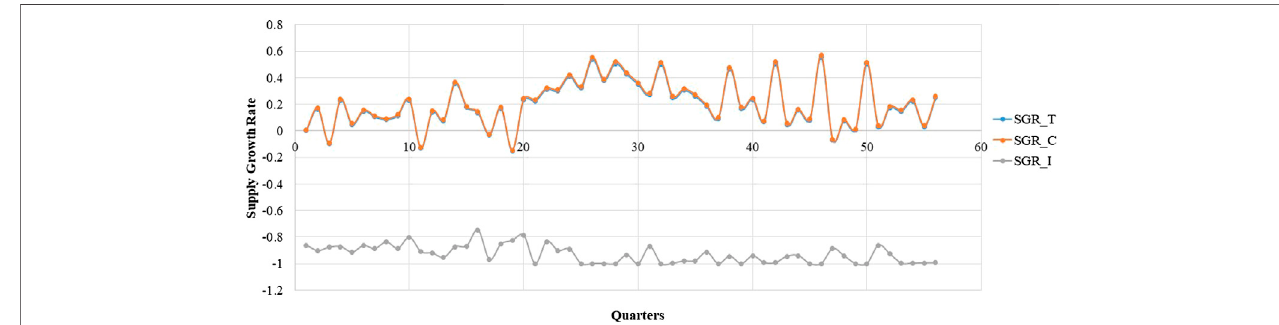
FIGURE 1 | The trend in the quarterly average supply growth rate of LPCMs in China from 2005 to 2018.